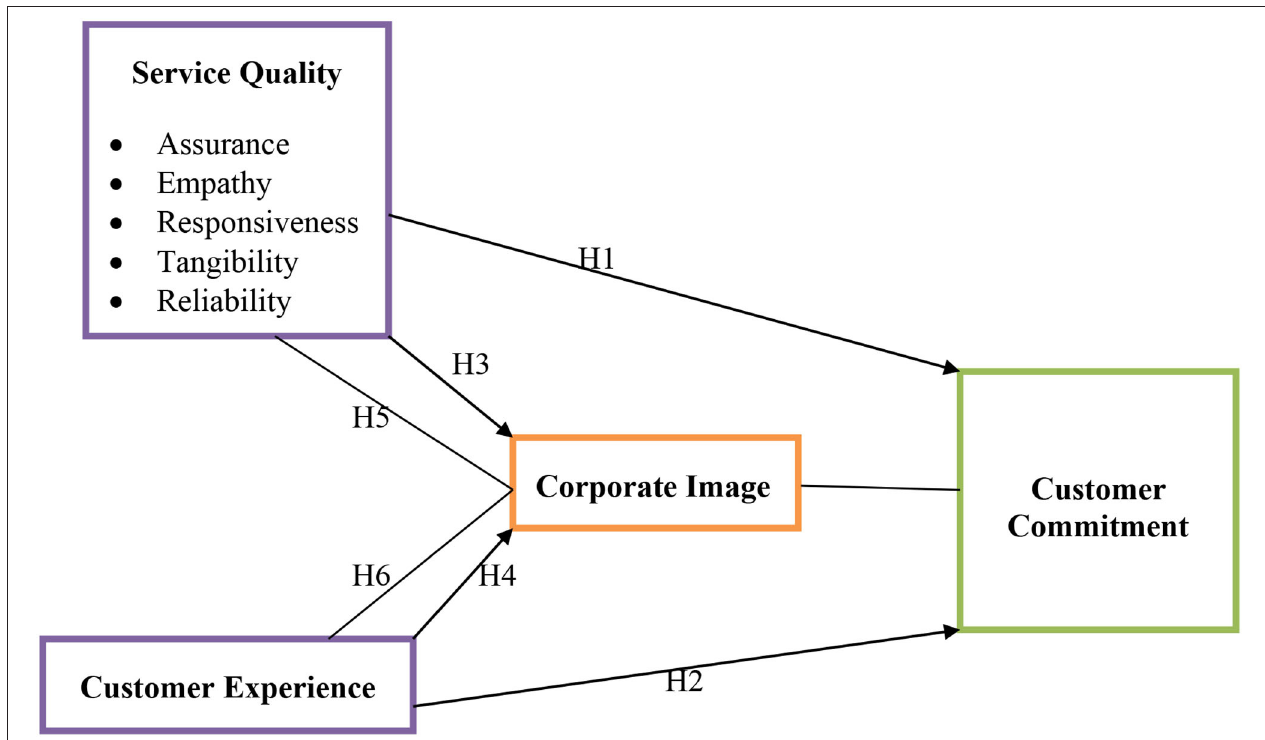
FIGURE 1 | Theoretical